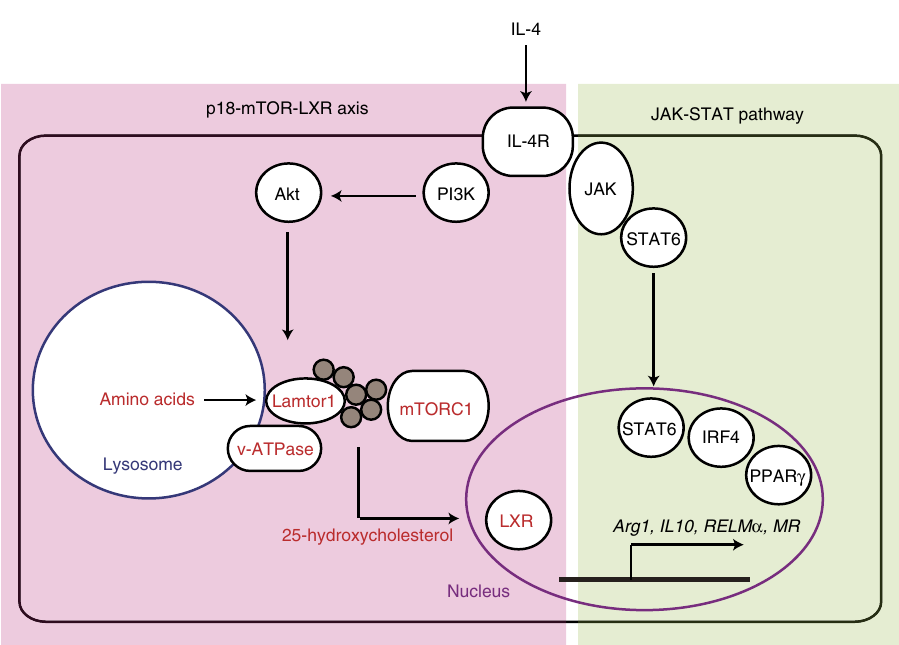
Figure 9 | Scheme of the present study. In addition to previously identified JAK (cid:2) STAT6 pathway, IRF4 and PPAR g , we demonstrated the essential role of a metabolic signaling axis consisting of the amino-acid sensing pathway (Lamtor1, v-ATPase and mTORC1) and downstream LXR in polarization of M2